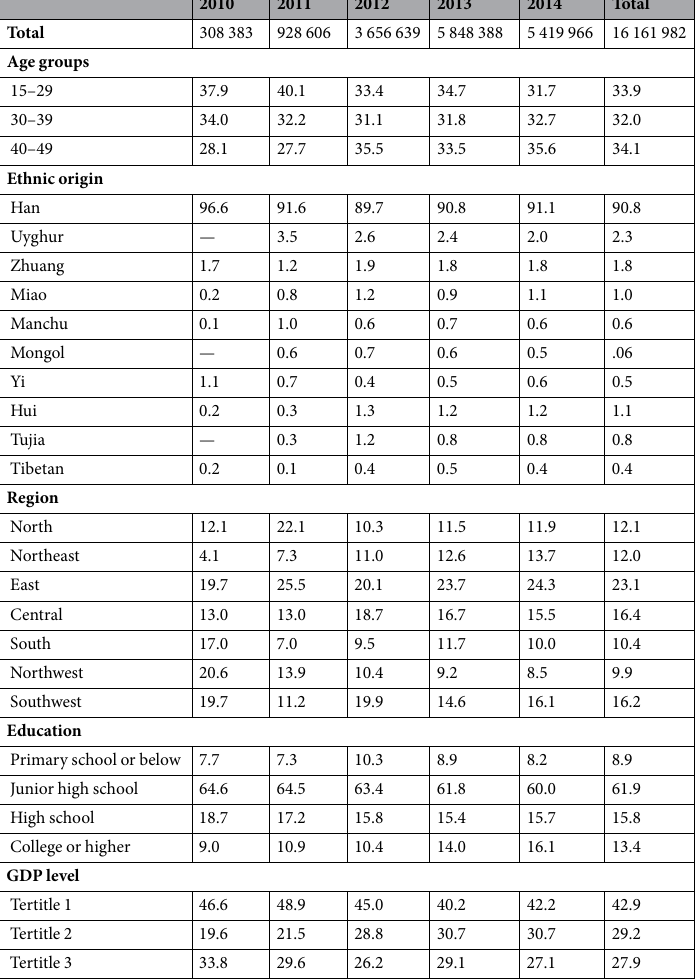
Table 1. Sample sizes and weighted proportion of demographic characteristics of reproductive-age men in rural China between 2010 and 2014 a . a The data are shown as percentage of participants in each year, and all proportion estimates were weighted using the China Population Census in